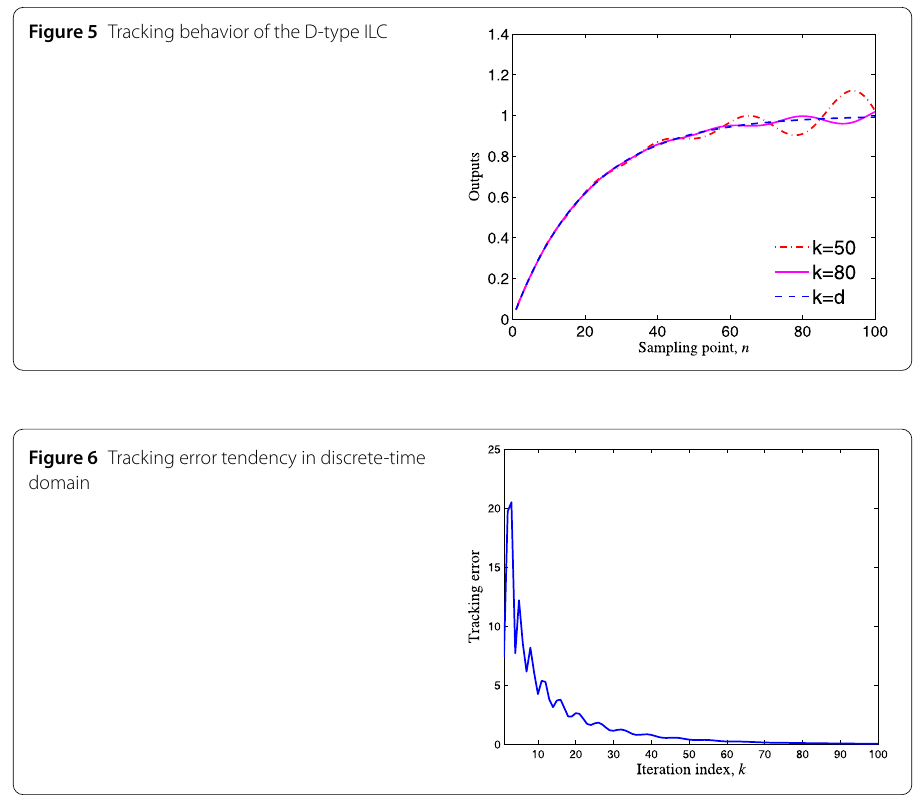
Figure 5 Tracking behavior of the D-type ILC